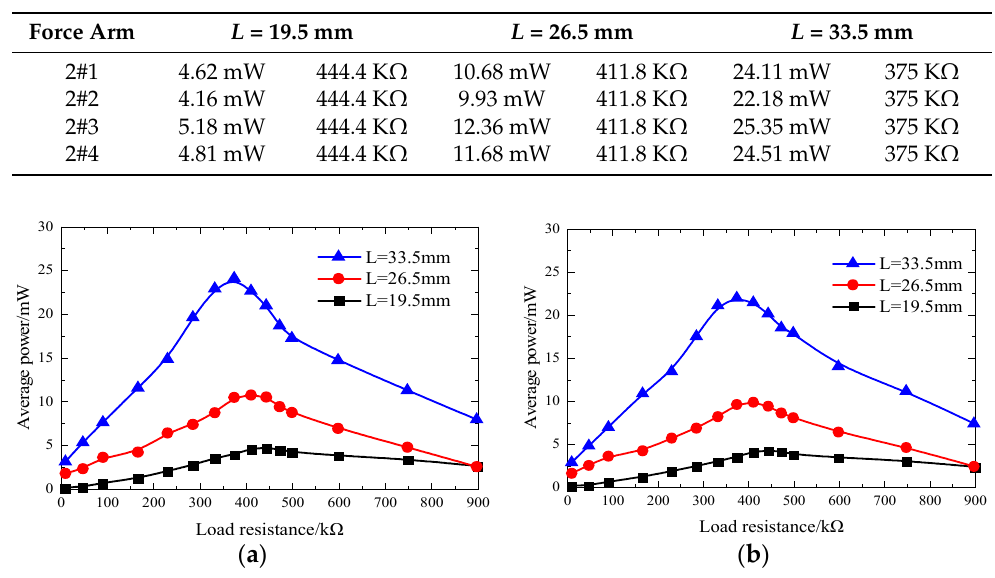
Table 3. The maximum average powers from 2#1–2#4 PZT4 patches on bimorph PCSs and the corresponding optimal load resistances ( F = 500 N, f = 1 Hz).